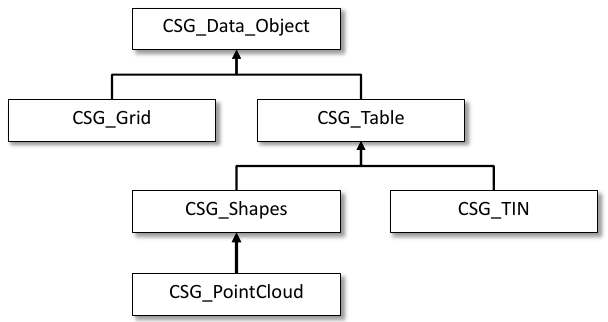
Figure 6. Data object